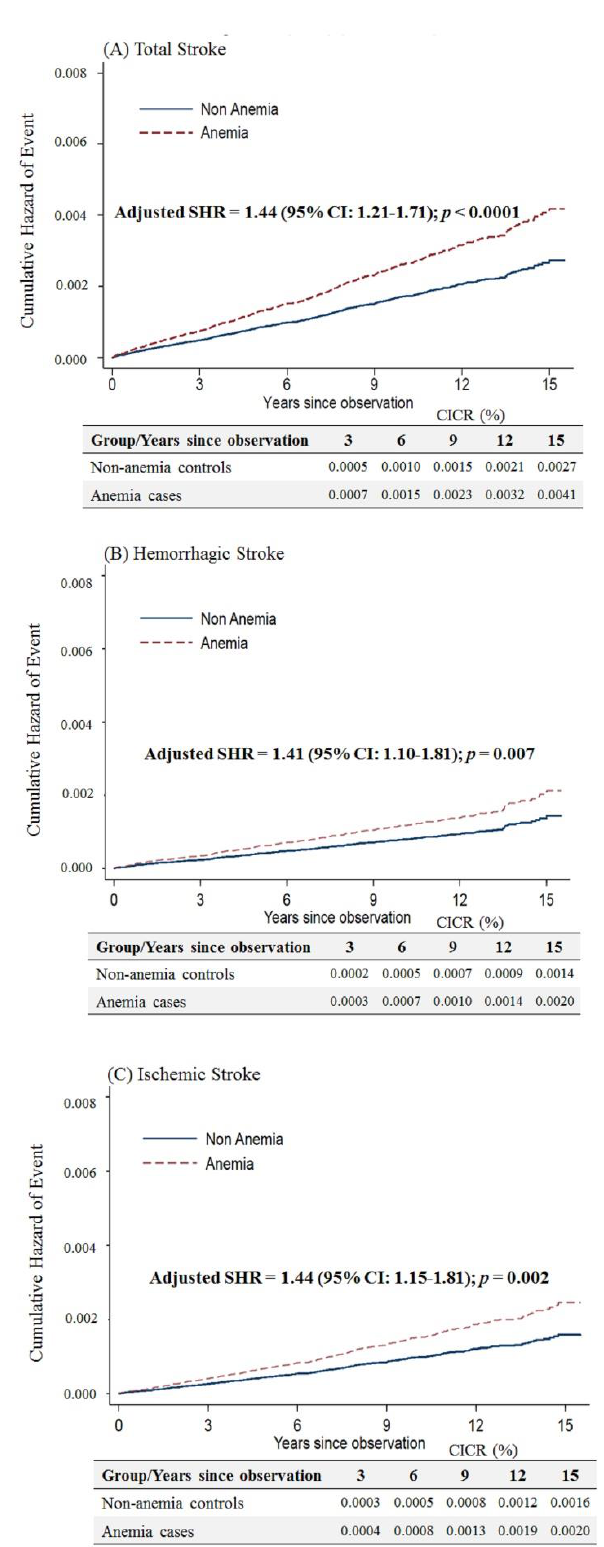
Figure 4. Cumulative incidences of competing risks (CICRs) of ( A ) total stroke, ( B ) hemorrhagic stroke and ( C ) ischemic stroke in anemia cases and non-anemia controls aged < 50 years and limited to a follow-up period up to 50 years of age.